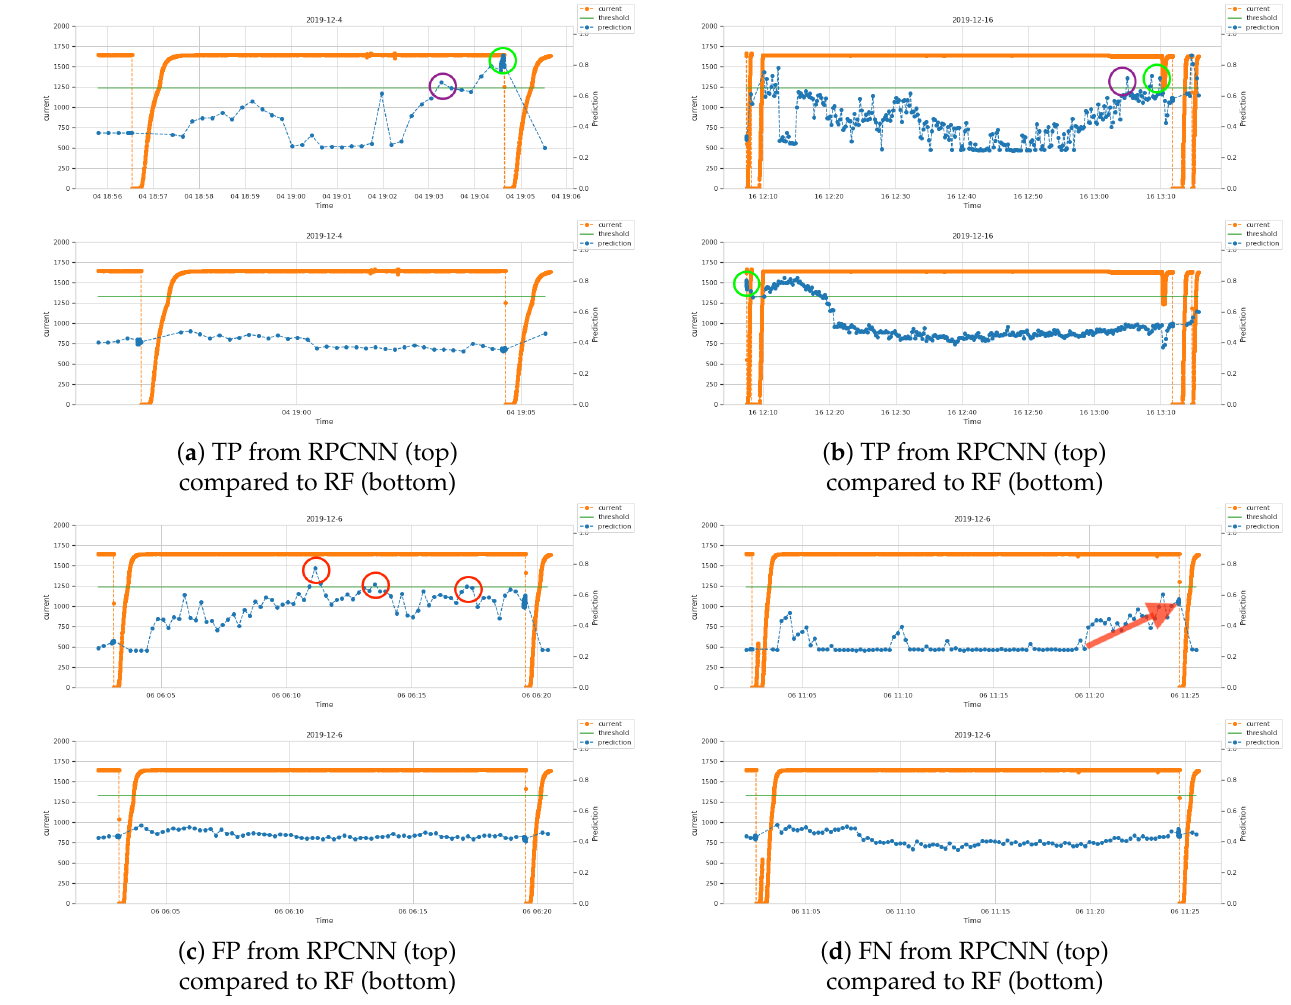
Figure 12. Screenshots from simulated live predictions over the validation data. The blue line is the prediction value from the model, with higher values indicating higher probability that interlocks are approaching. The orange line is the readout of the beam current channel “MHC1:IST:2” where a drop to zero indicates an interlock. The green line is the binary classification threshold, here taking 0.65 for the RPCNN and 0.7 for the RF. ( a , b ) show two examples of successful prediction of interlocks by RPCNN compared to the result of RF on the same time periods. The positive predictions closer to interlocks are regarded as TP marked by green circles, and the earliest times that the model output cross the threshold are enclosed in purple circles. ( c ) shows the FPs from the RPCNN in red circles, compared to the result of RF. ( d ) shows an example of FN from the RPCNN compared to the result of RF. A clear trend increasing with time is present in the output of RPCNN, shown by the red